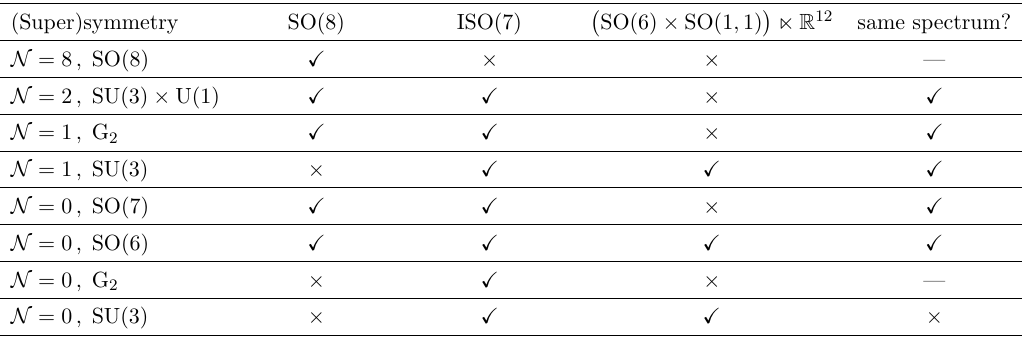
Table 1 . Possible residual (super)symmetries, regardless of their E in the SU(3)-invariant sector of the three di(cid:11)erent gaugings that we